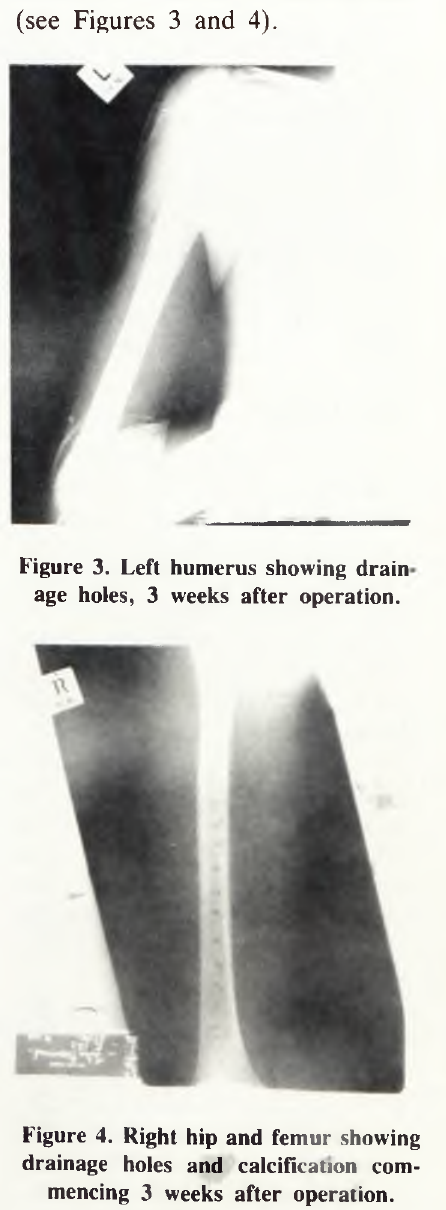
Figure 1. Left shoulder and humerus showing Osteitis. 15.1.81.